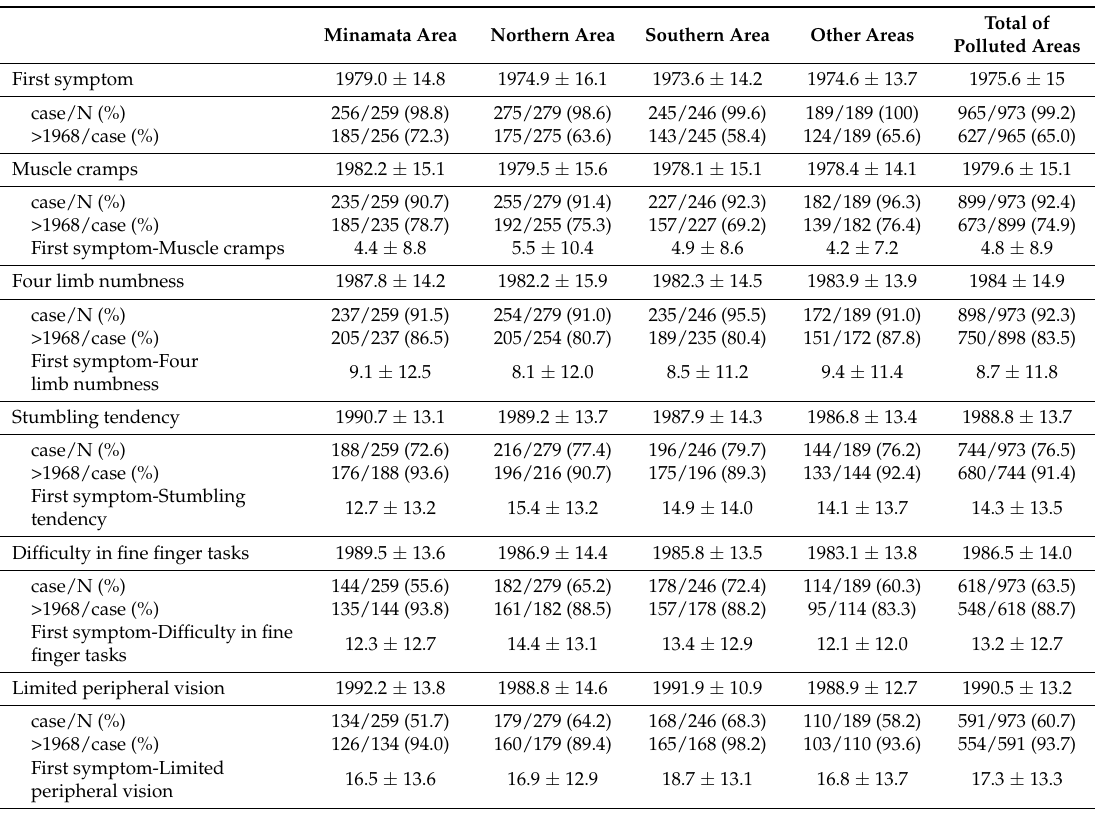
Table 12. Average onset year of symptoms and interval between the first symptom and the onset of each following symptom in each area. Minamata Area Northern Area Southern Area Other Areas